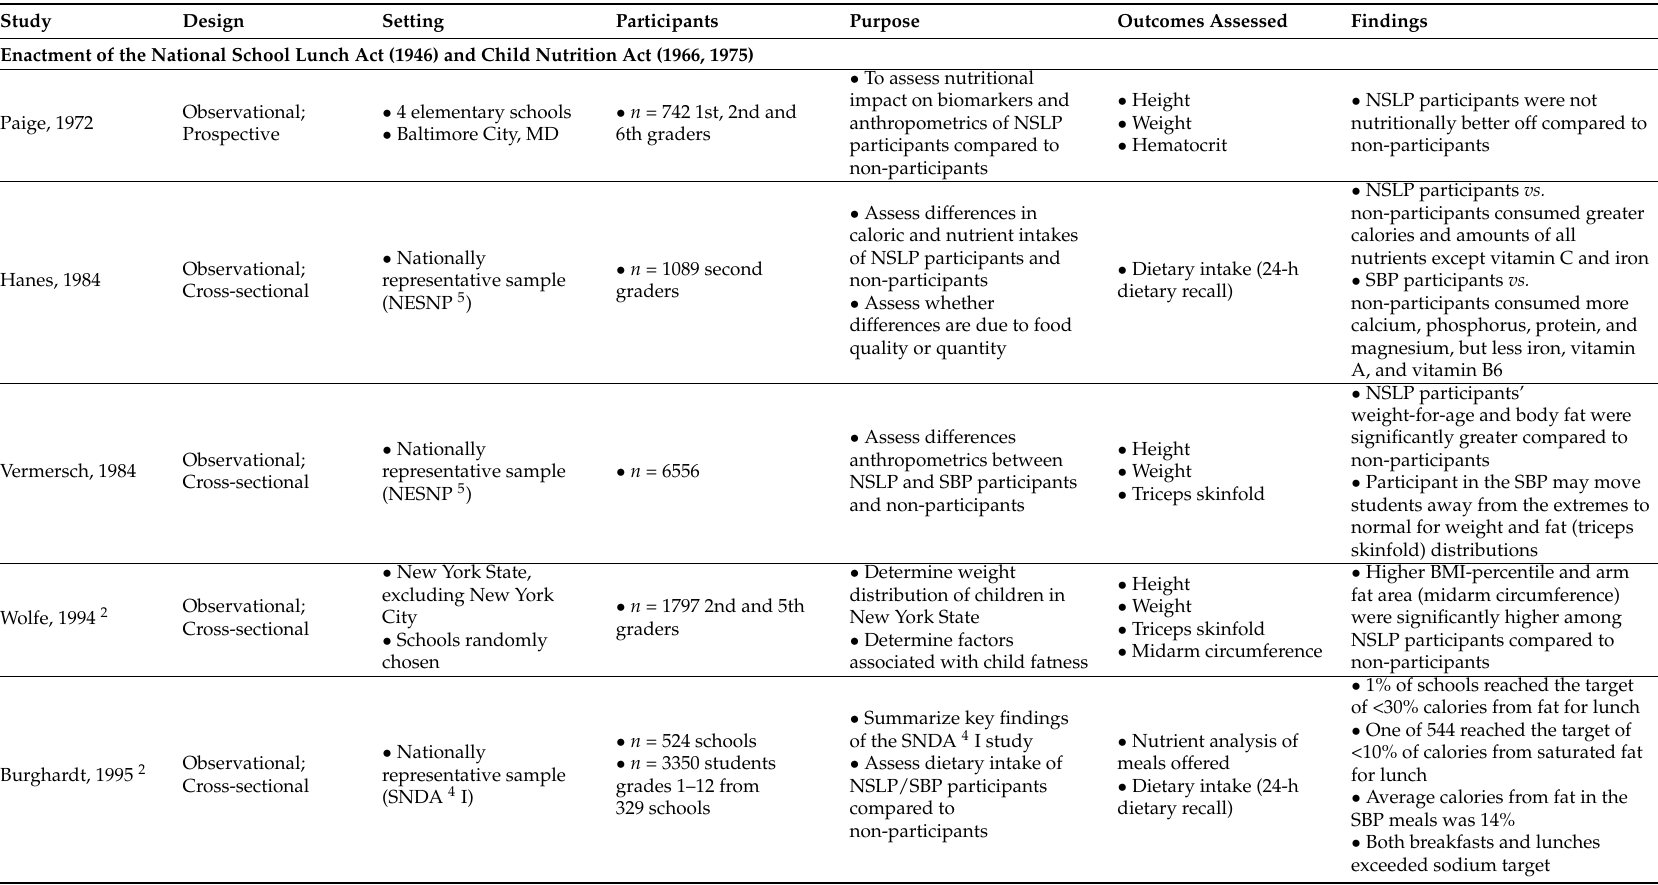
Table 1. Summary of Studies Published in the Peer-Reviewed Literature Assessing the Nutritional Adequacy of the USDA National School Lunch Program (NSLP) and School Breakfast Program (SBP) Meals and Dietary Intakes and Nutritional Outcomes of NSLP and SBP Participants in Correspondence with Historical Events (Enactments and Nutrition Standard Revisions) of the NSLP and SBP 1